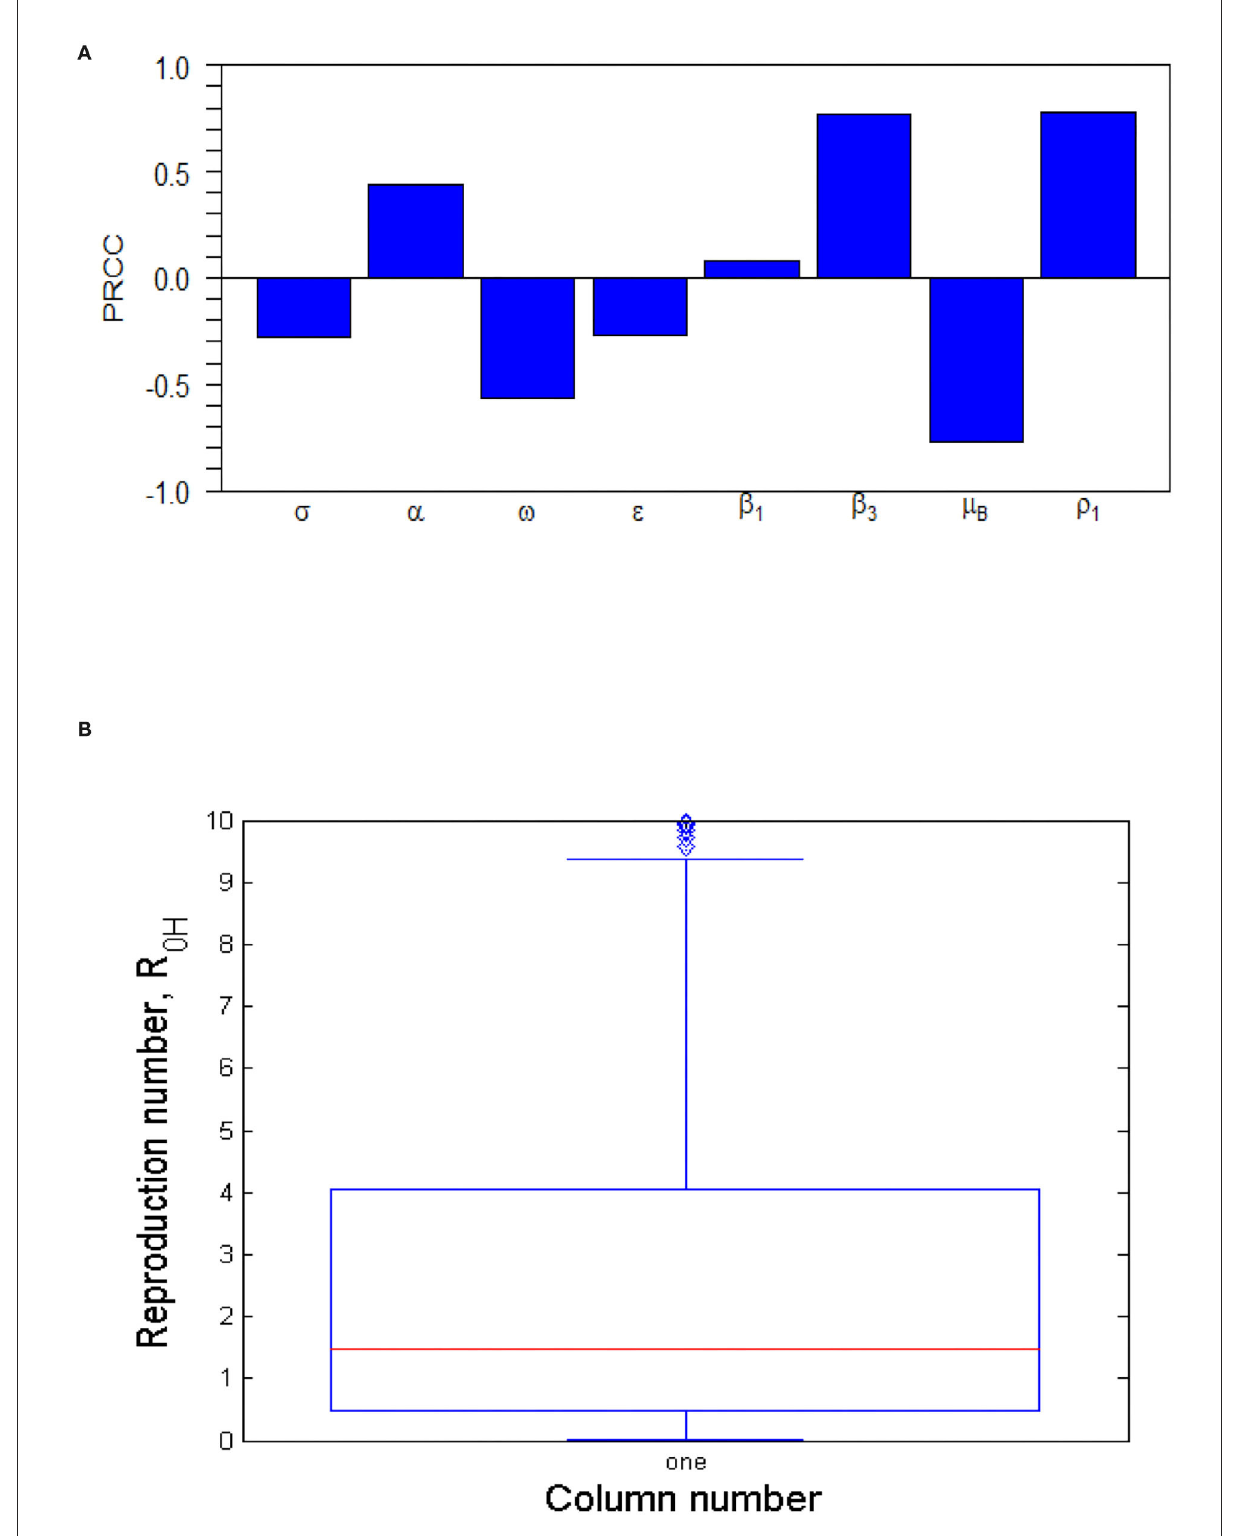
FIGURE4 (A) Tornado plot of Partial Rank Correlation Coefficient (PRCC) values for some important parameters of R 0 H . The parameter values (ranges) used are given in Table 2. (B) Box plot of R 0 H . The parameter values (ranges) used are given in Table